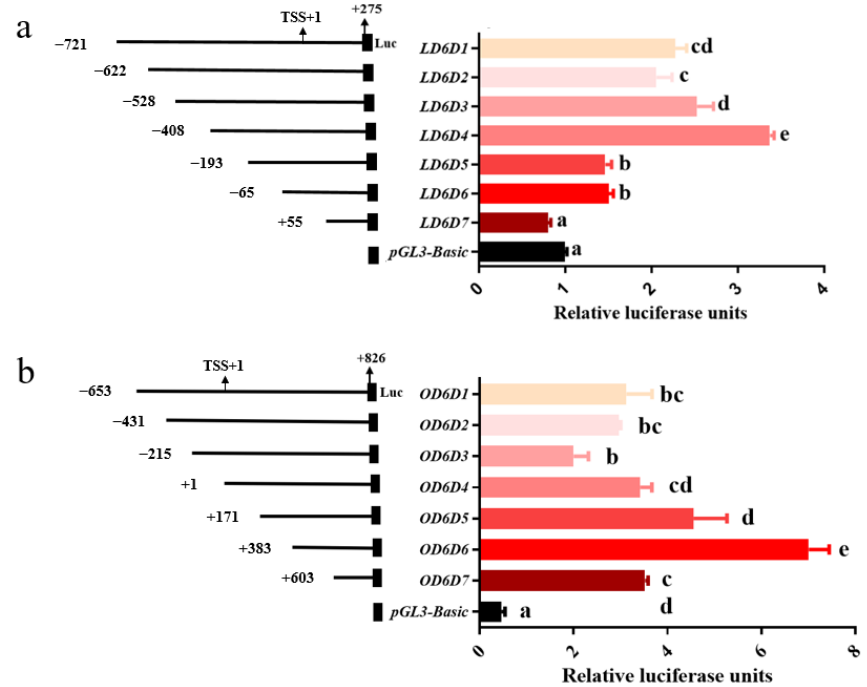
Figure 3. The deletion analysis of fads2 promoter of large yellow croaker ( a ) and rainbow trout ( b ). Deletion mutant constructs are represented on the left. Sequences are numbered relative to the putative transcription start site. Luciferase coding by closed boxes. Promoter activities are represented on the right. The values represent normalized activity (Firefly luciferase/Renilla luciferase) relative to the pGL3-Basic (as a control). TSS: transcription start site. Bars without sharing a common letter are significantly different ( p < 0.05).